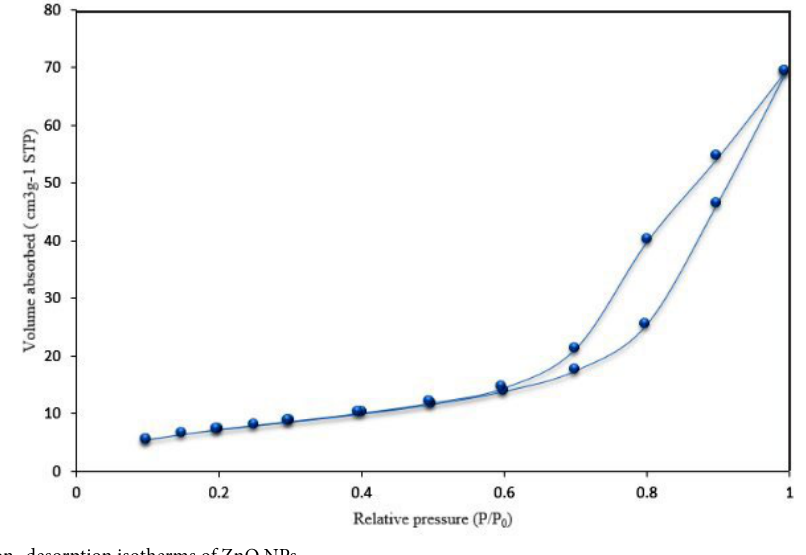
Figure 3. N 2 adsorption- desorption isotherms of ZnO